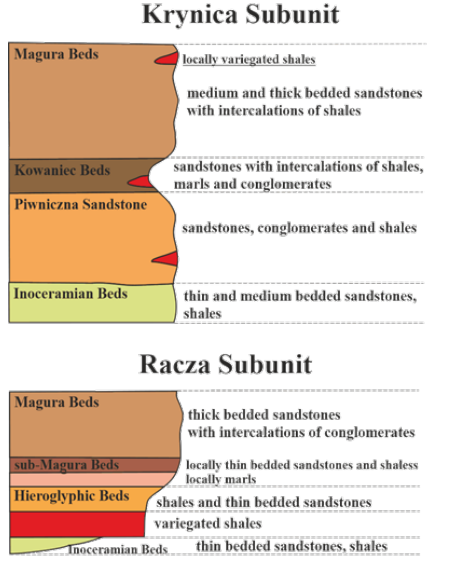
Figure 3. Lithostratigraphy of the Krynica, Bystricam and Racza subunits in the area of Rabka-Zdrój; after [29]; changed.